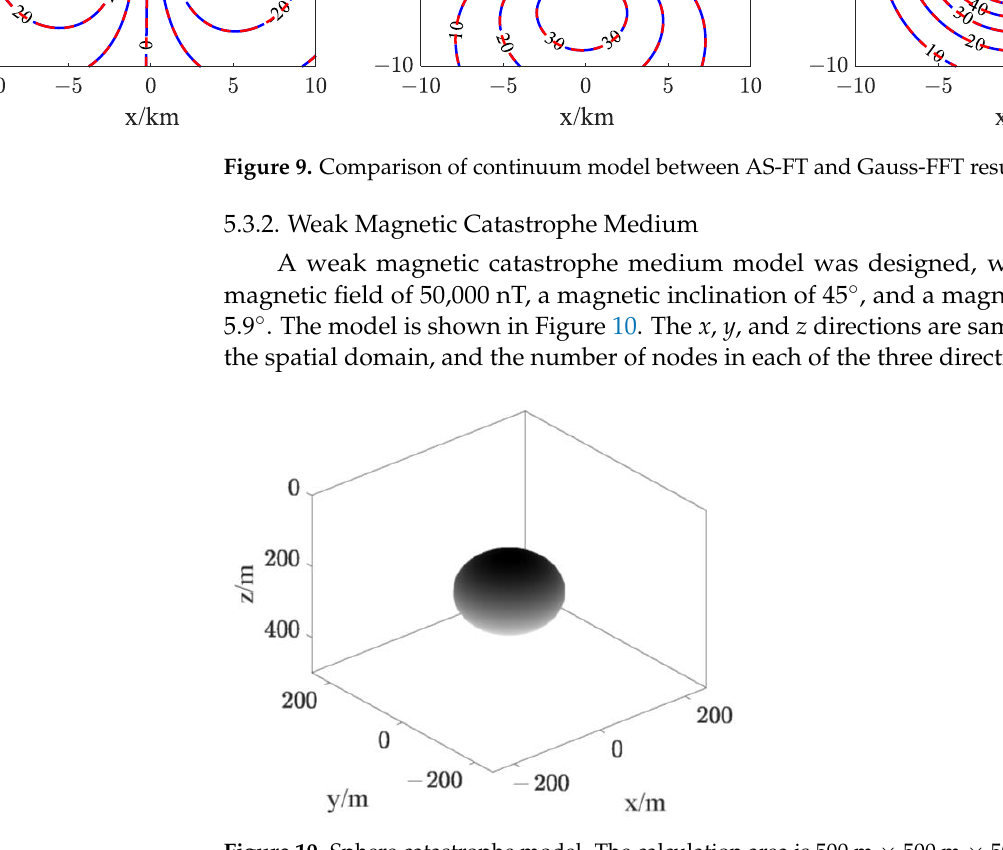
Figure 10. Sphere catastrophe model. The calculation area is 500 m × 500 m × 500 m, with a range of − 250 m–250 m in the x direction, − 250 m–250 m in the y direction, and 0–500 m in the z direction. The center of the abnormal sphere model is located at (0 m, 0 m, 250 m). The radius of the sphere is 100 m. The magnetic susceptibility of the sphere is 0.01 SI.